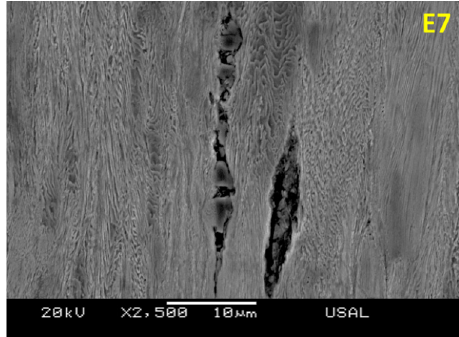
Figure 12. Axial micro-cracks generated in a heavily cold drawn pearlitic steel (commercial prestressing steel wire) created during the manufacturing process by cold drawing.